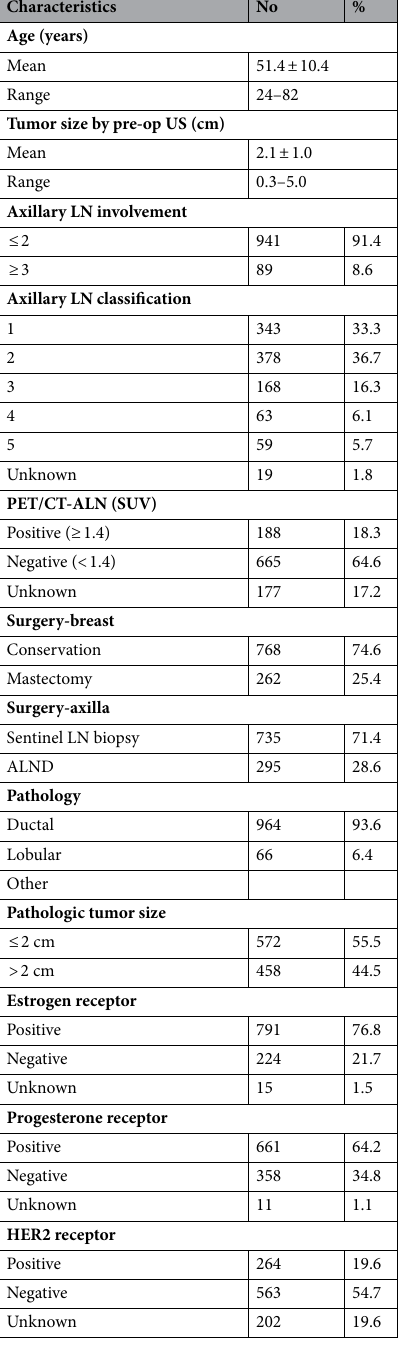
Table 1. Patient characteristics of the training set (N = 1030). Pre-op , Preoperative; US , Ultrasonography; LN , Lymph node; ALN , Axillary lymph node; PET/CT , Positron emission tomography/computed tomography; ALND , Axillary lymph node dissection; HER2 , Human epidermal growth factor receptor